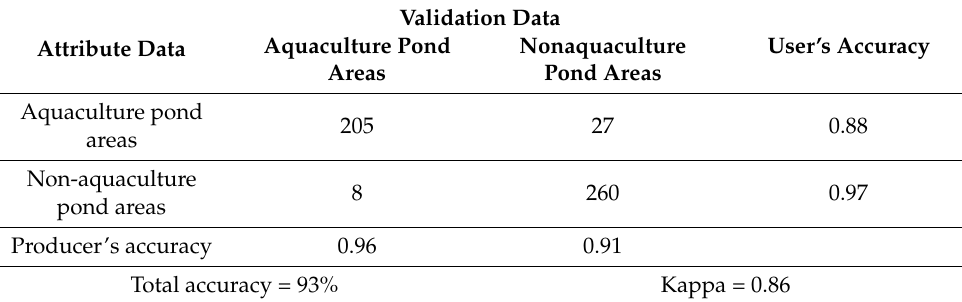
Table 1. Confusion matrix of extraction results.